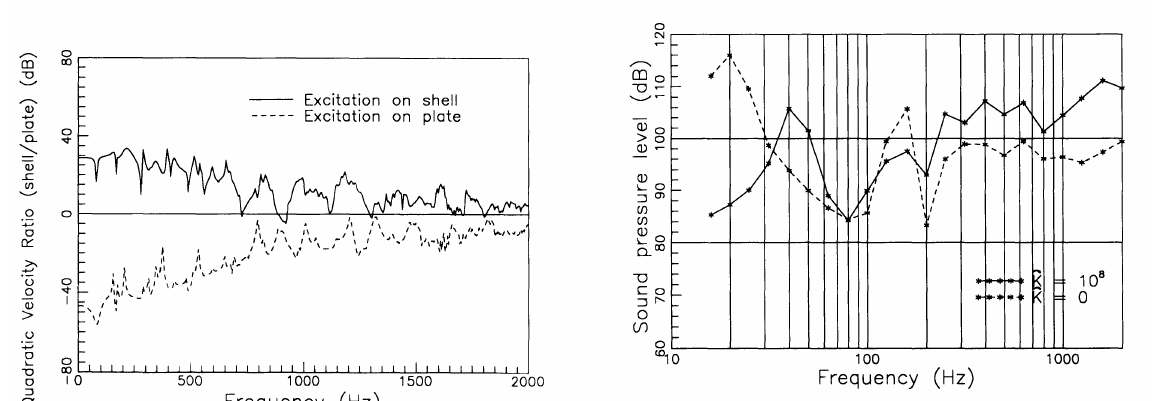
FIGURE 9 Average sound pressure level inside the cavity in one-third octave bands with two limiting shell-plate joint conditions in